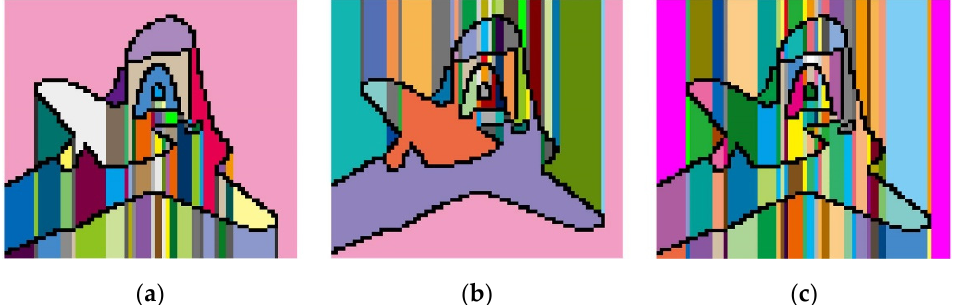
Figure 4. An example of initial homogenous region generation. ( a ) Scan from top to bottom; ( b ) scan from bottom to top; and ( c ) the joint initial map that combines both directions into the vertical direction.